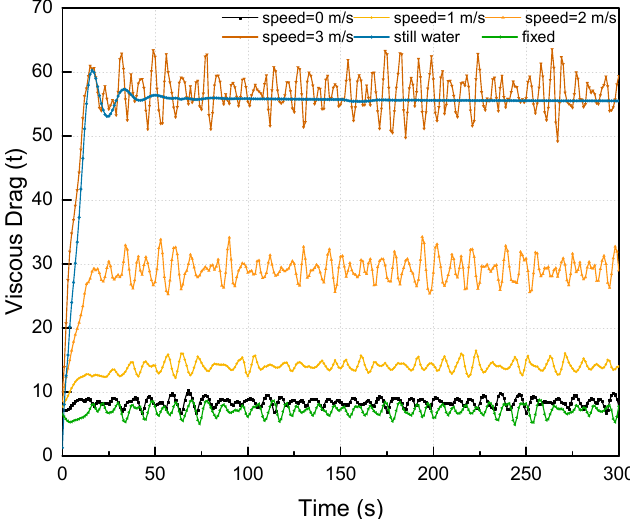
Figure 6. Comparison between the time history curves of the viscous drag force under different towing speeds for submerged towing (submerged depth: 40 m).